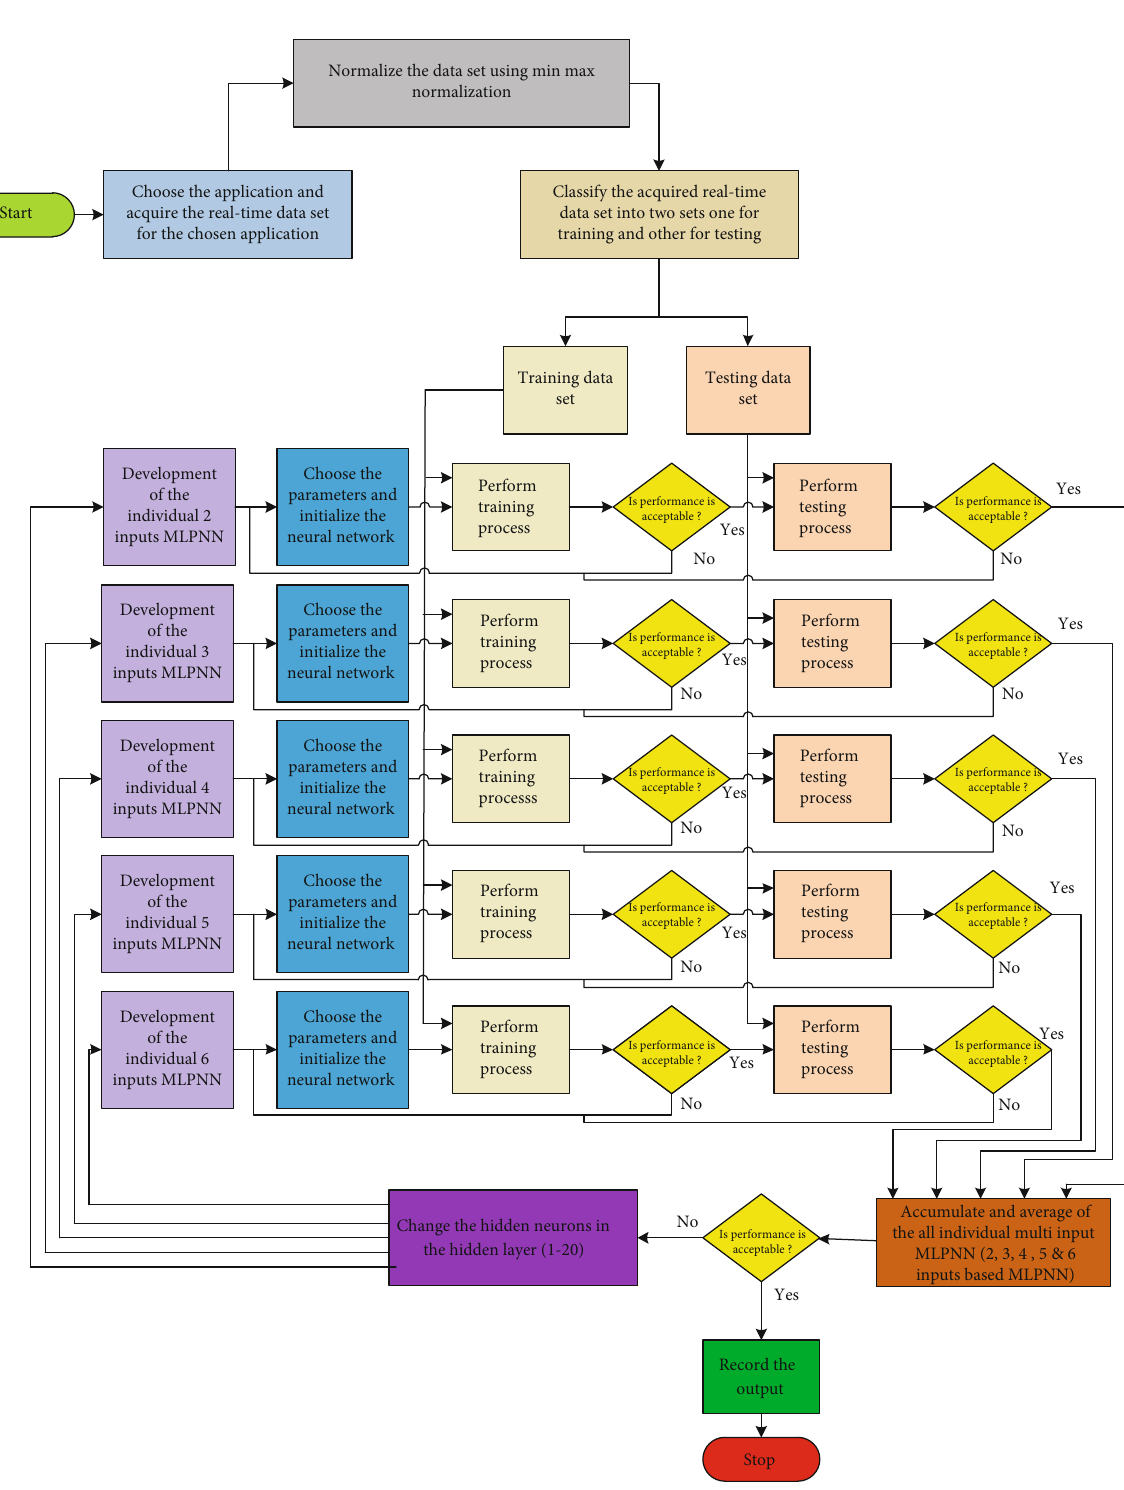
Figure 2: The process fl ow of the proposed cooperative multi-input multilayer perceptron neural network. Note: The MSE, RMSE, MAE, MRE, MAPE, R , and convergence time are chosen as the performance